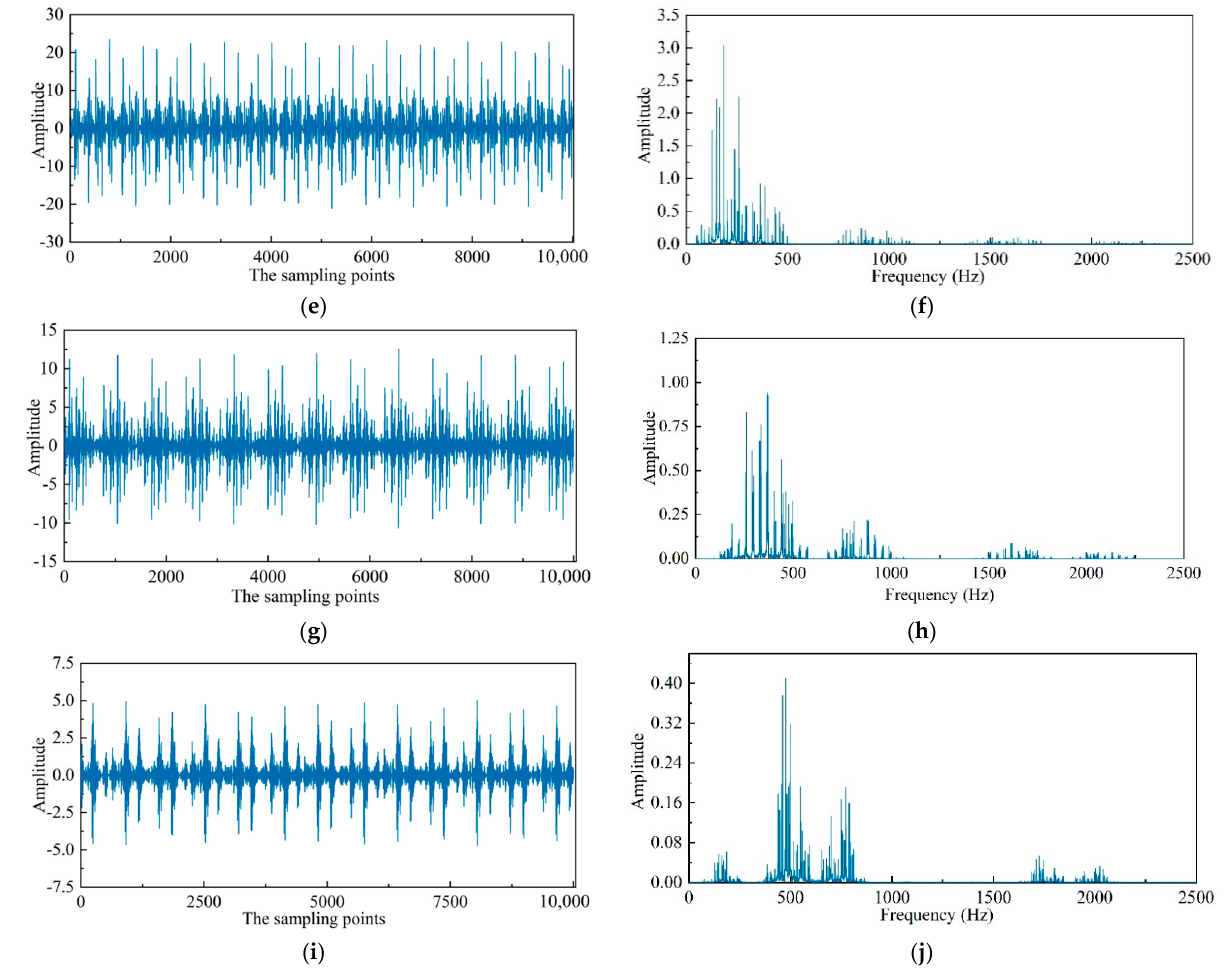
Figure 10. The original cutting force and corresponding wavelet packet transform results of the first four nodes. ( a ) The original cutting force signals; ( b ) The schematic diagram of cutting force; ( c ) The reconstructed wavelet packet coefficients of the first node ( d ) The corresponding power spectrum of the first node; ( e ) The reconstructed wavelet packet coefficients of the second node; ( f ) The corresponding power spectrum of the second node; ( g ) The reconstructed wavelet packet coefficients of the third node; ( h ) The corresponding power spectrum of the third node; ( i ) The reconstructed wavelet packet coefficients of the fourth node; ( j ) The corresponding power spectrum of the fourth node.